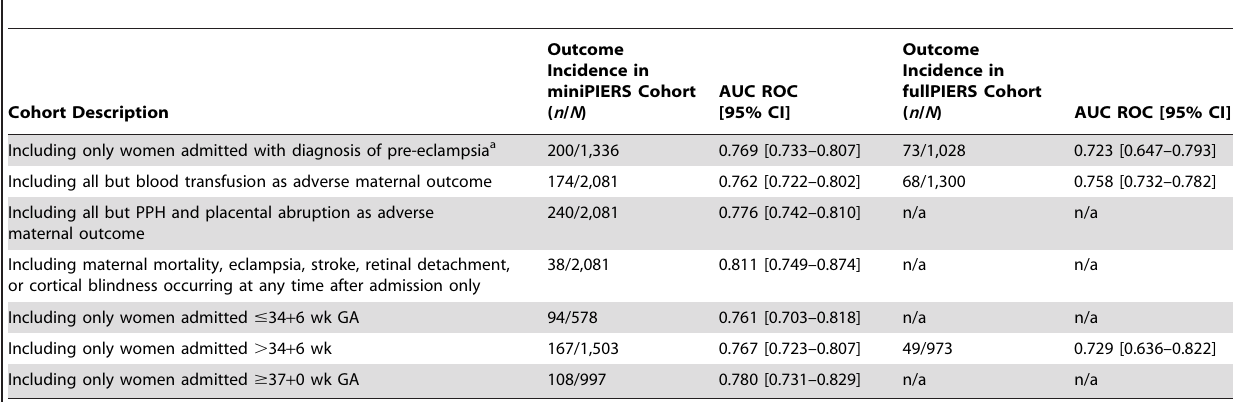
Table 6. Results of sensitivity analysis using the miniPIERS model to predict adverse maternal outcome in subsets of the data or to predict restricted definition of the combined adverse outcome, as described, in the miniPIERS and fullPIERS